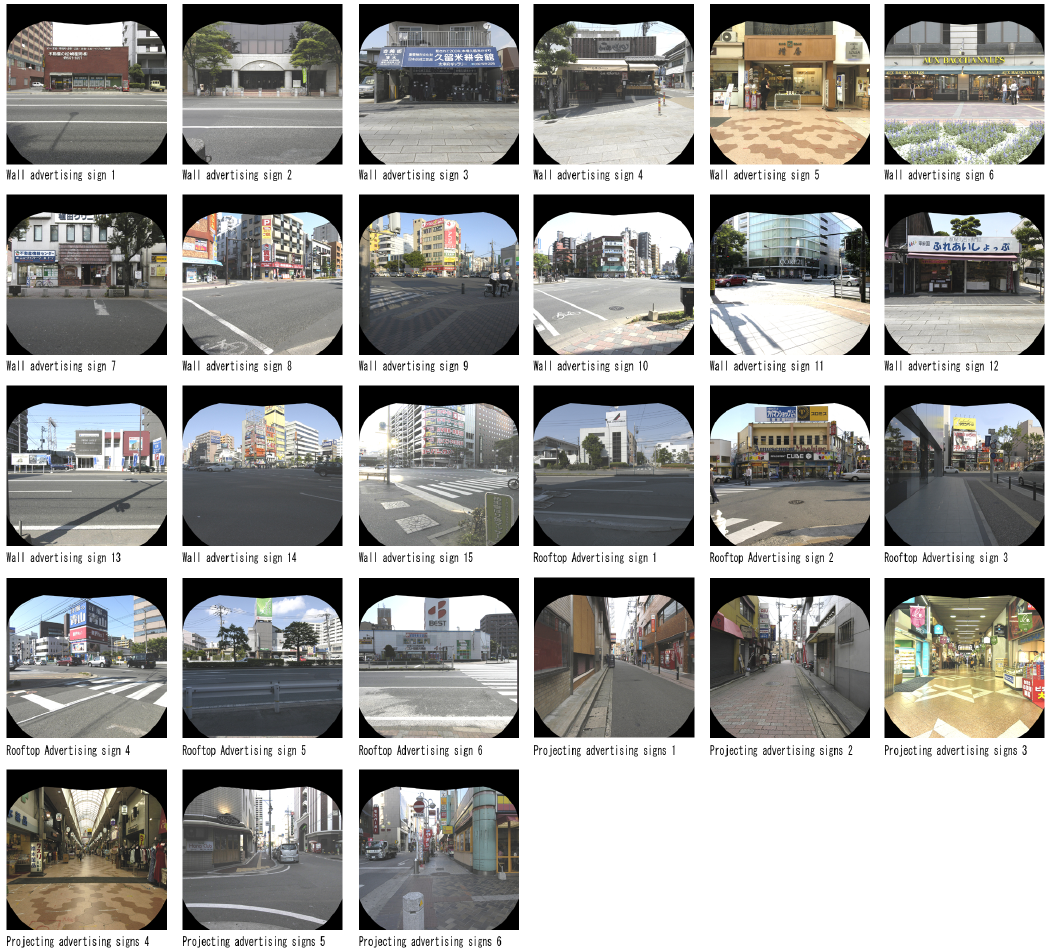
Figure 2. Urban outdoor advertisement sample. The images used in this study were taken in Fukuoka town.